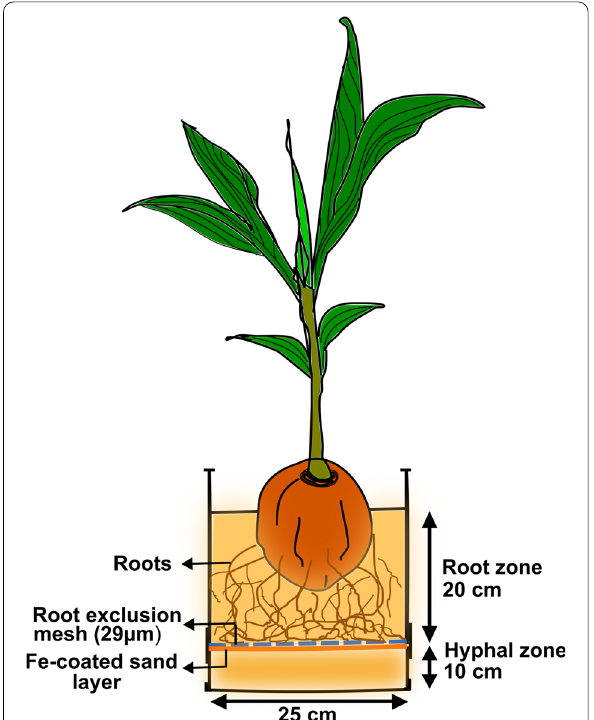
Fig. 1 Schematic representation of the root-exclusion study container